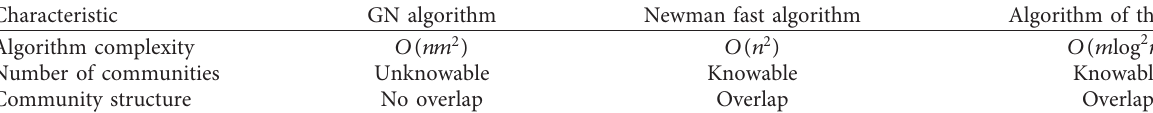
Table 3: Method comparison.